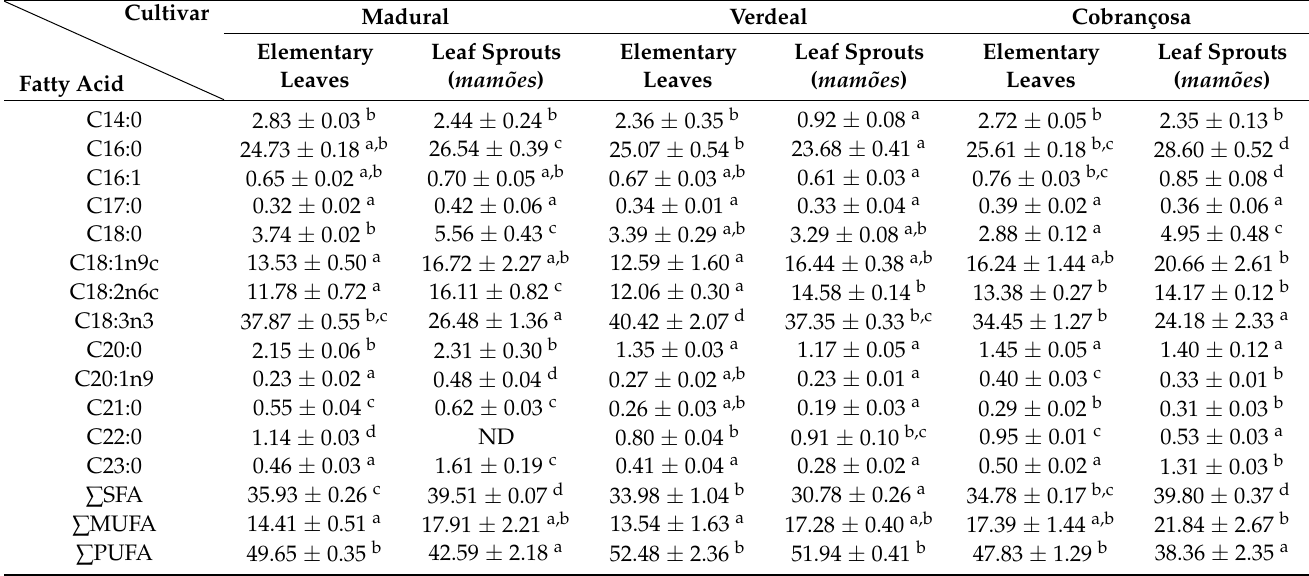
Table 4. Fatty acids profile of different varieties of olive